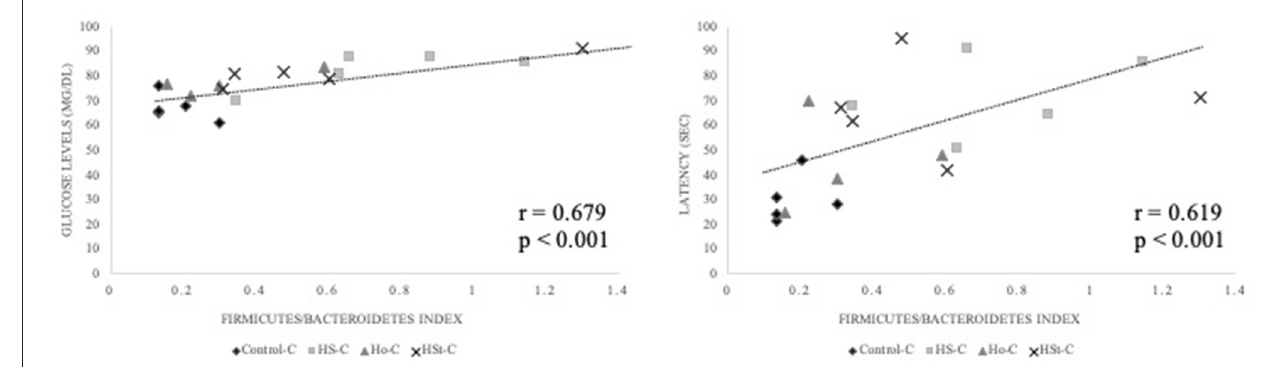
FIGURE 9 | Correlations between the F/B index with glucose levels (mg/dl) and latency (s) in Barnes maze of adult male offspring rats. Spearman’s rank correlations were conducted taking into consideration Control-C ( n = 5), HS-C ( n = 4), Ho-C ( n = 4), and HSt-C ( n = 5). Results were considered statistically significant when p <